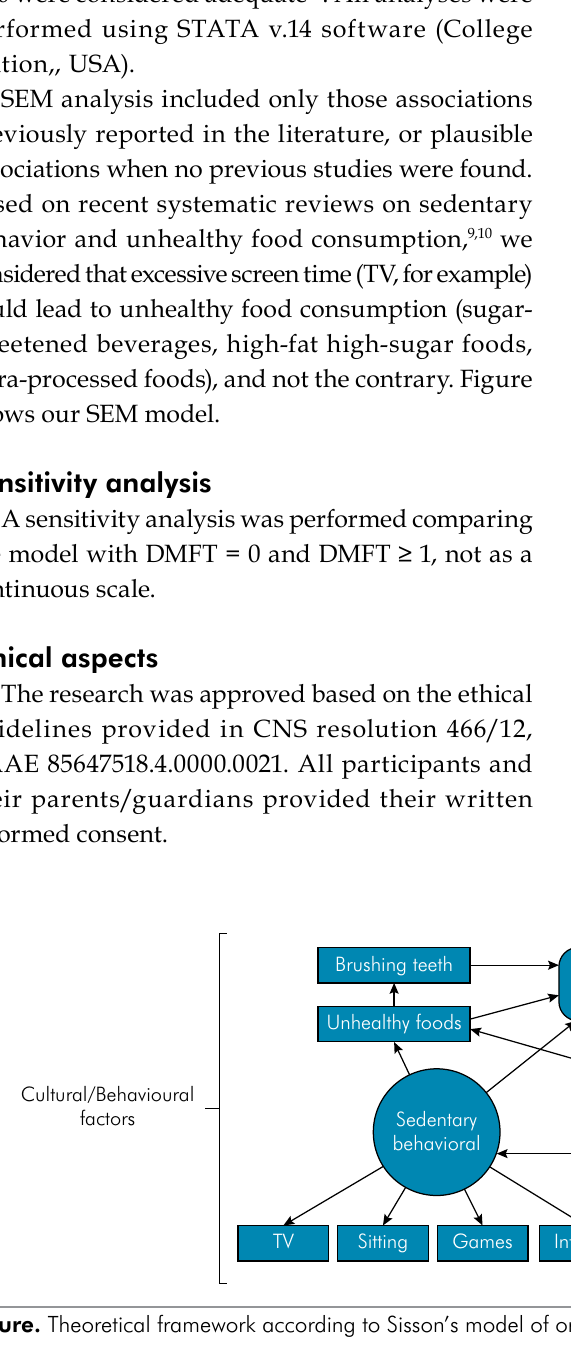
Figure. Theoretical framework according to Sisson’s model of oral health inequalities.